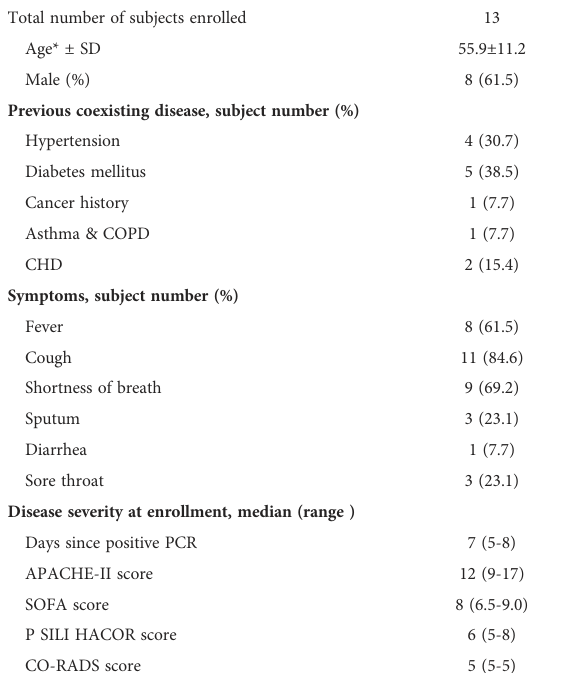
TABLE 1A DemographicsandclinicalstatusbeforechipEXO TM treatment.